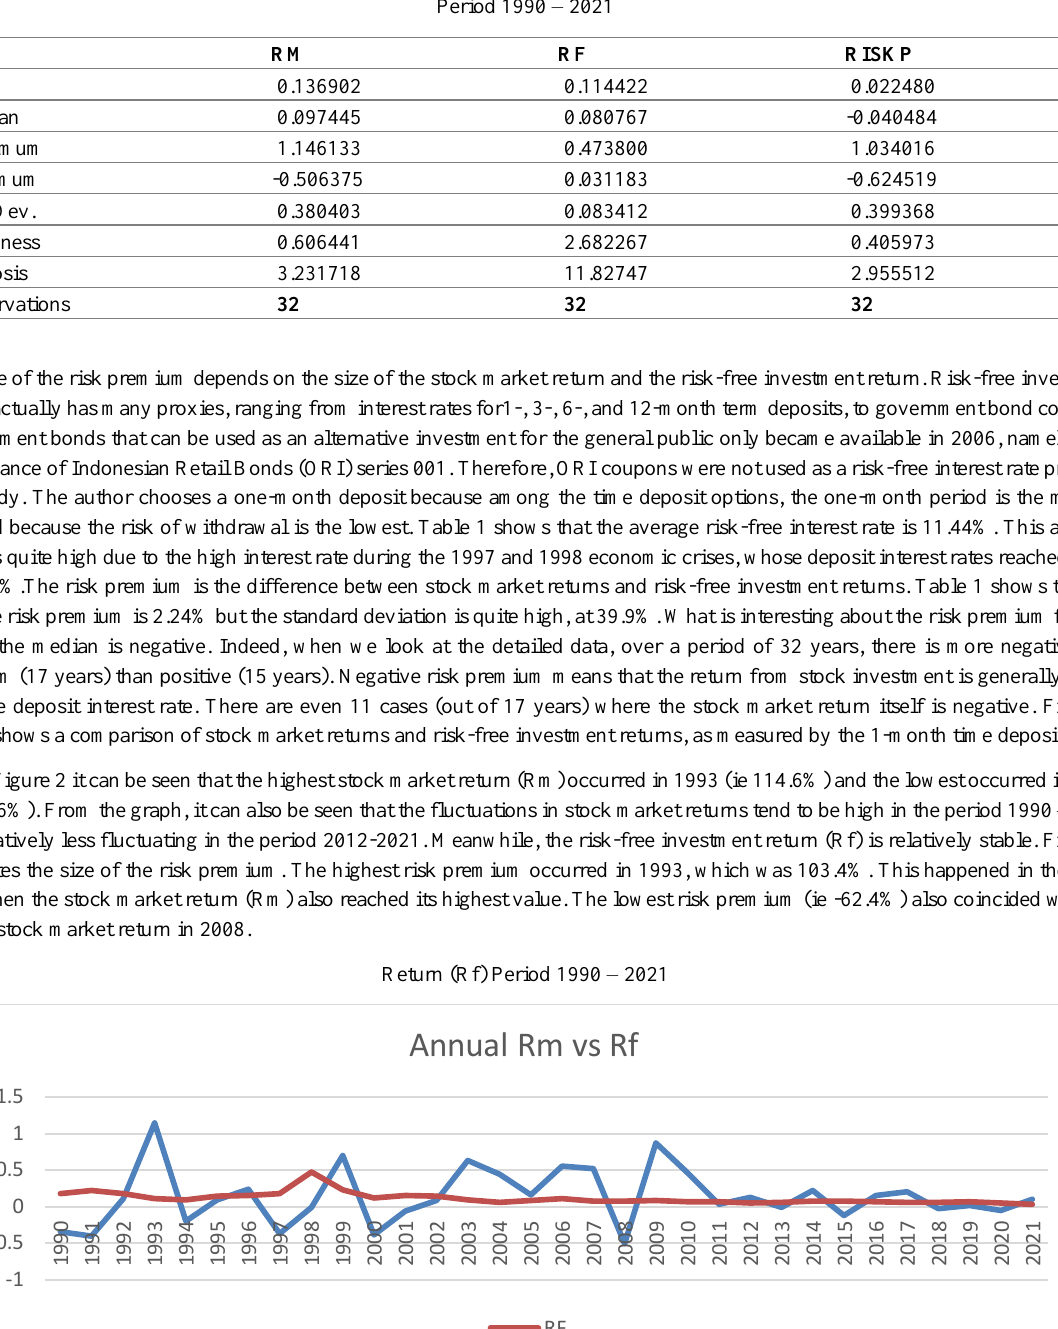
Table 1: Annual Market Return, Risk-Free Interest Rate and Risk Premium